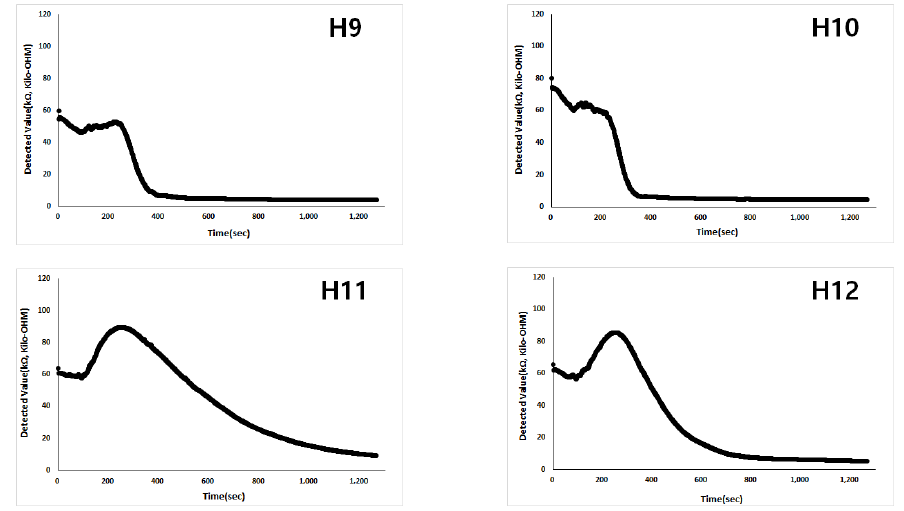
Figure 8. Variation of H9 – H12 CdS photoresistors in sludge sedimentation detecting.